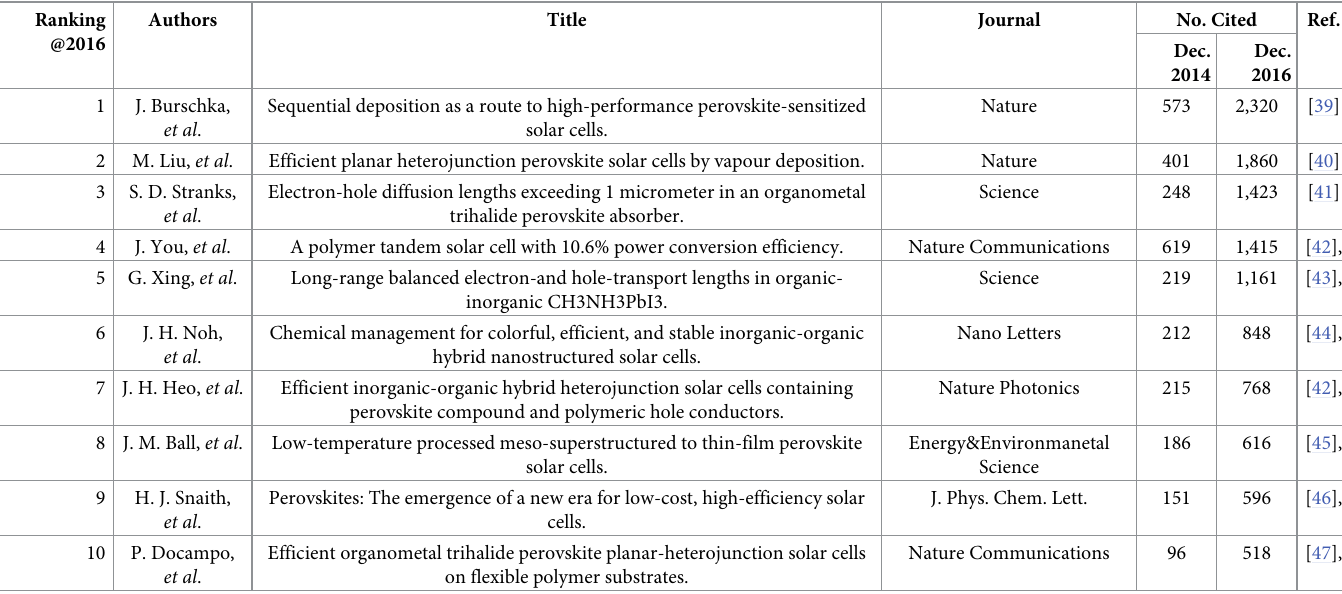
Table 3. Ranking of citations for papers published in 2013 in the dataset.